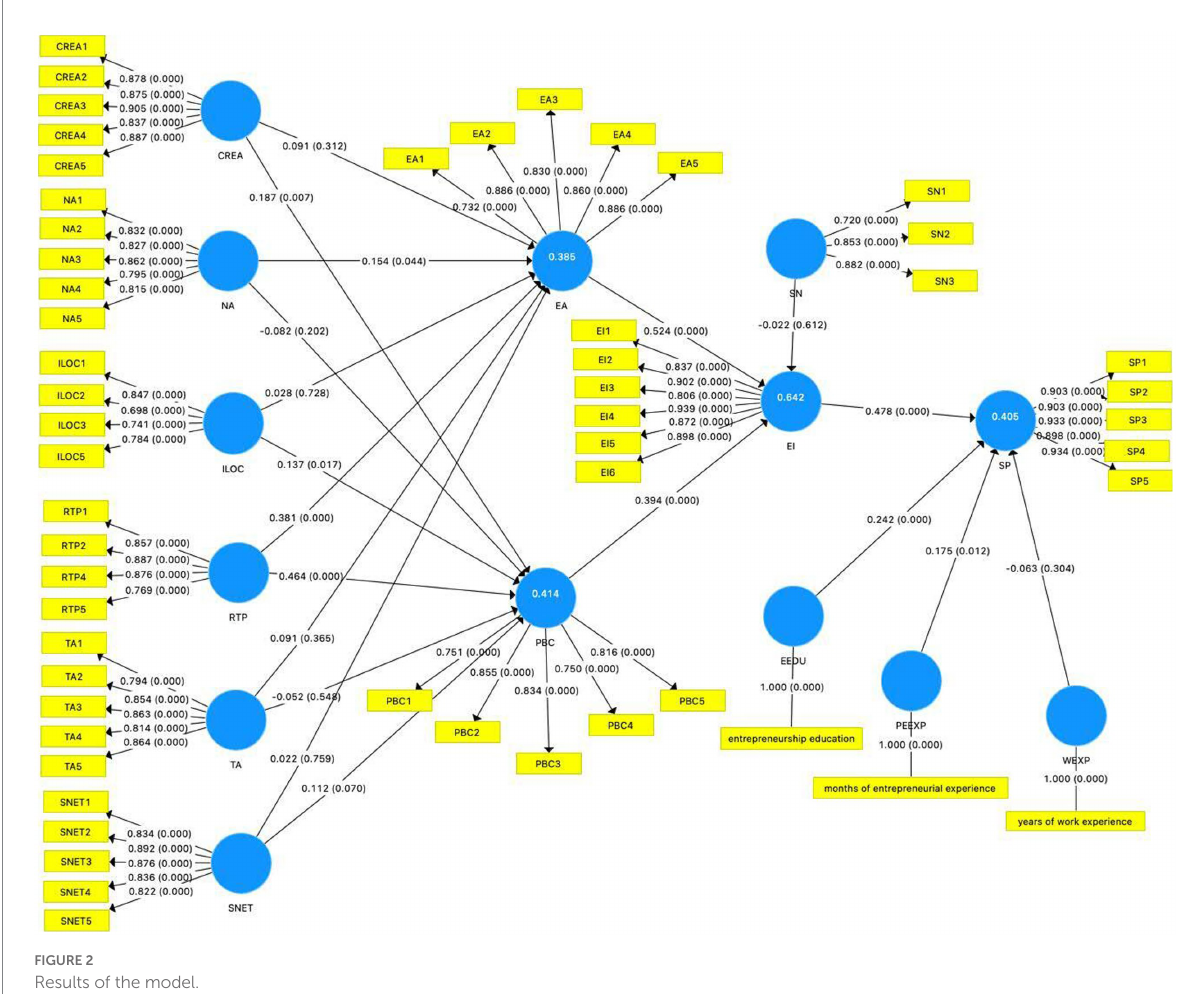
FIGURE 2 Results of the